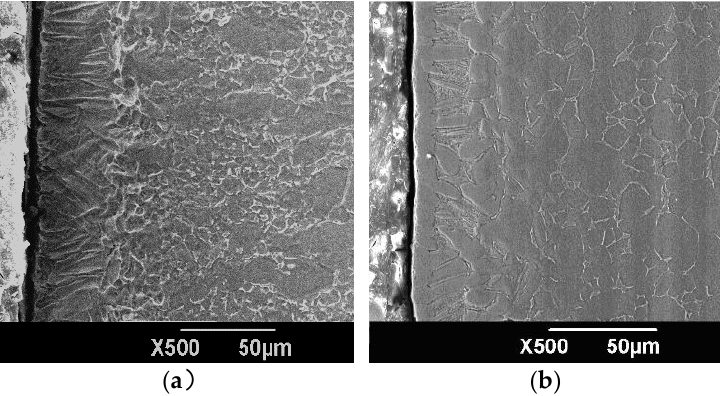
Figure 6. Cross-sectional microstructure of ( a ) ZrN and ( b ) ZrN+SP layers on Ti6Al4V alloy. Materials 2016 , 9 , 217